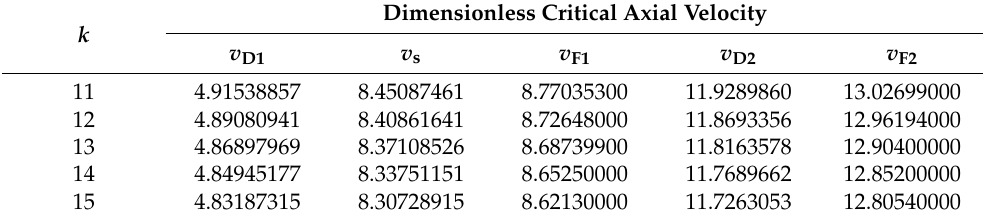
Table 6. The effects of gradient parameter k of material on the dimensionless critical axial velocities of FGM beam (CS).